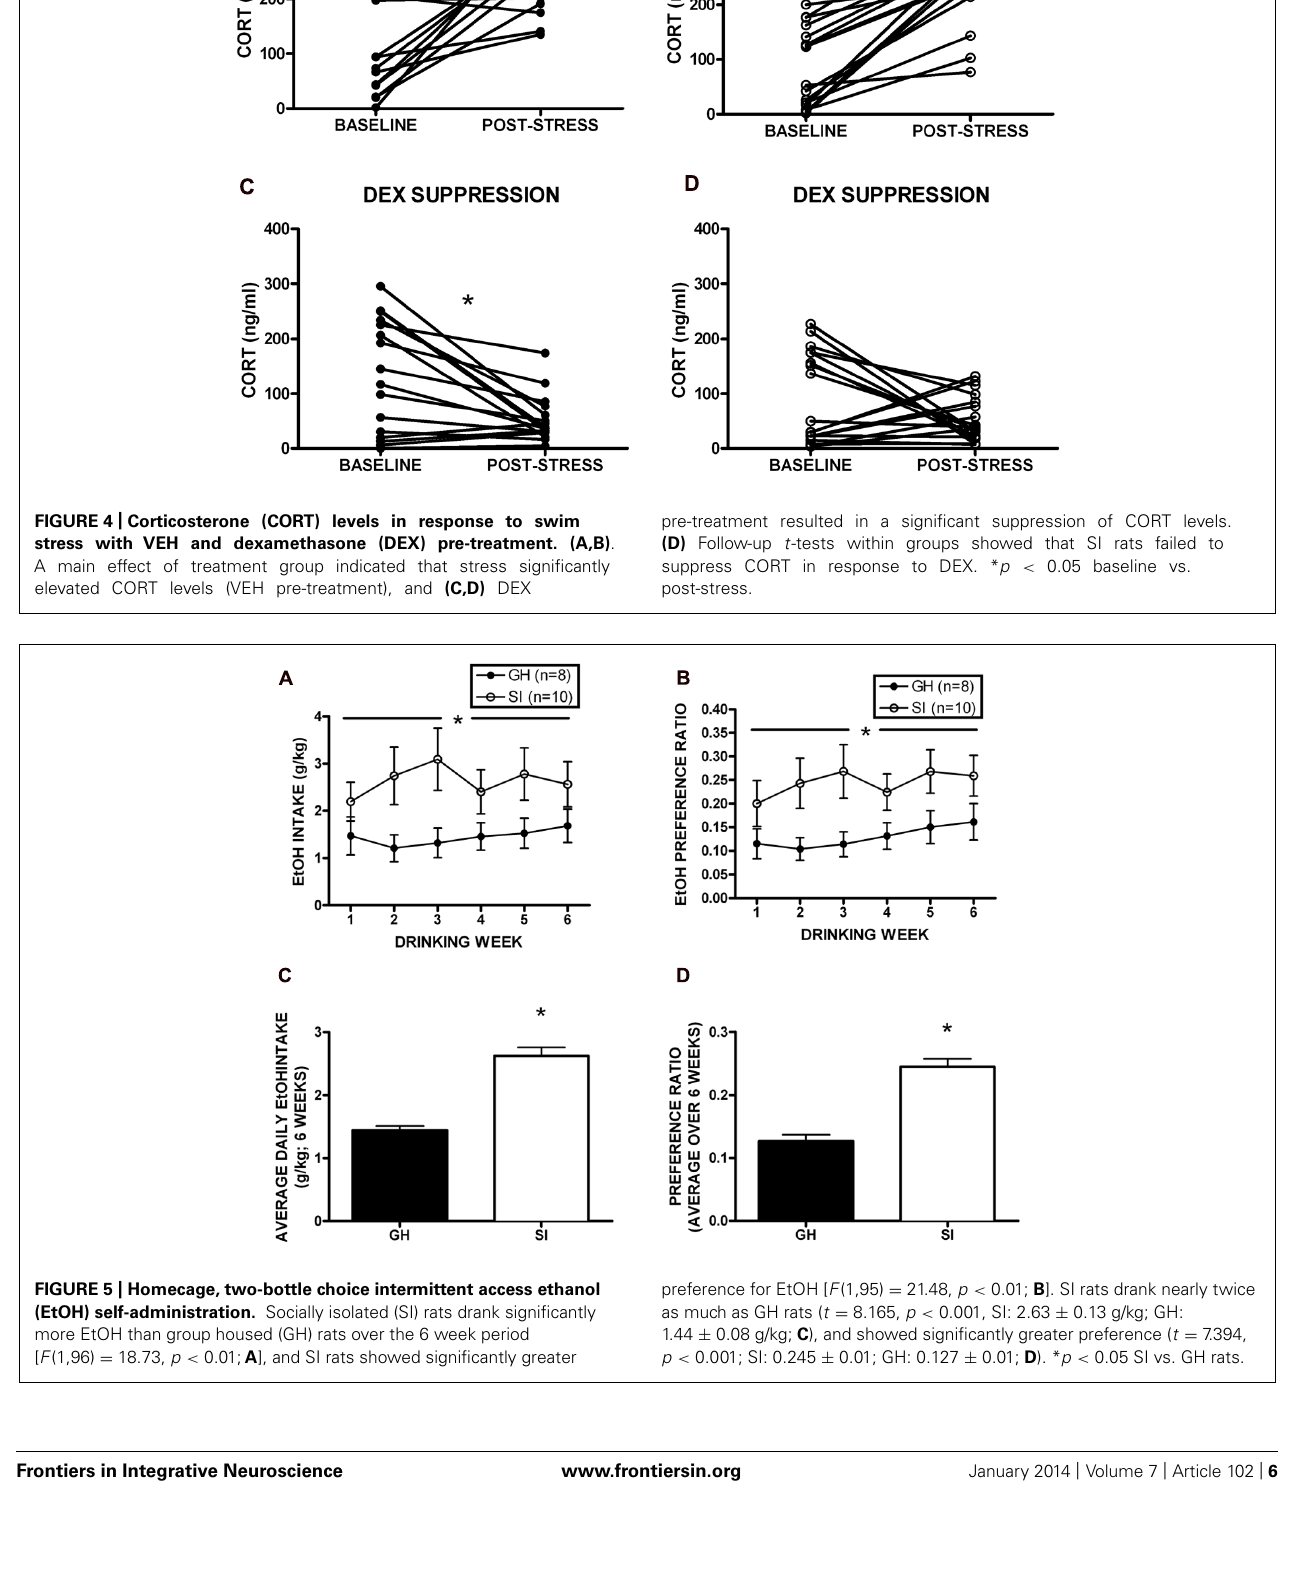
preference for EtOH [ F (1,95) = 21.48, p < 0.01; B ]. SI rats drank nearly twice as much as GH rats ( t = 8.165, p < 0.001, SI: 2.63 ± 0.13 g/kg;